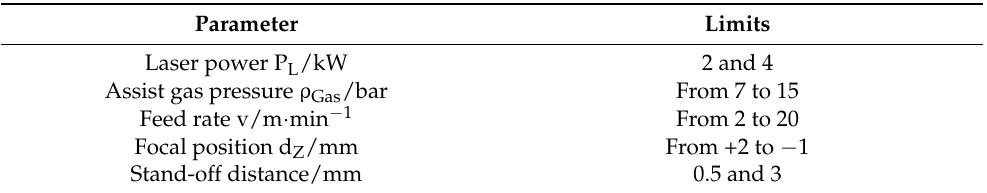
Table 3. Process parameters and their limits for exploration of dross parameter space in phase one of